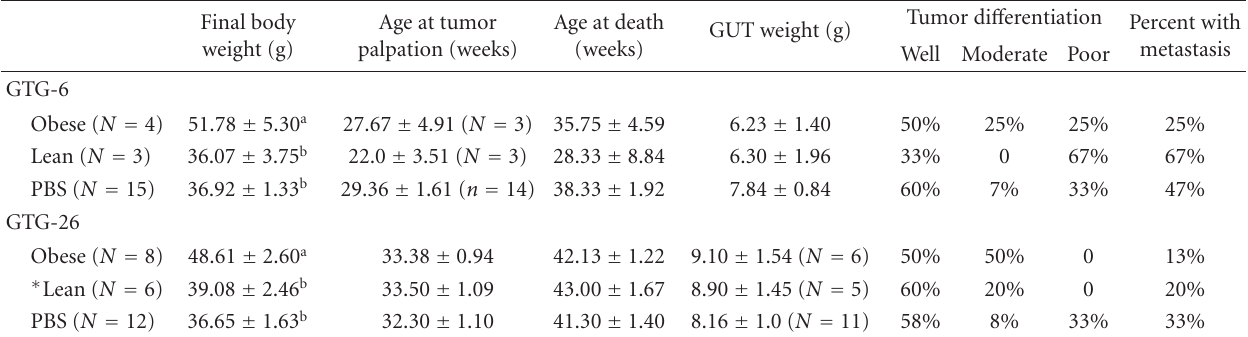
Table 1: End-point comparisons for TRAMP GTG male mice §